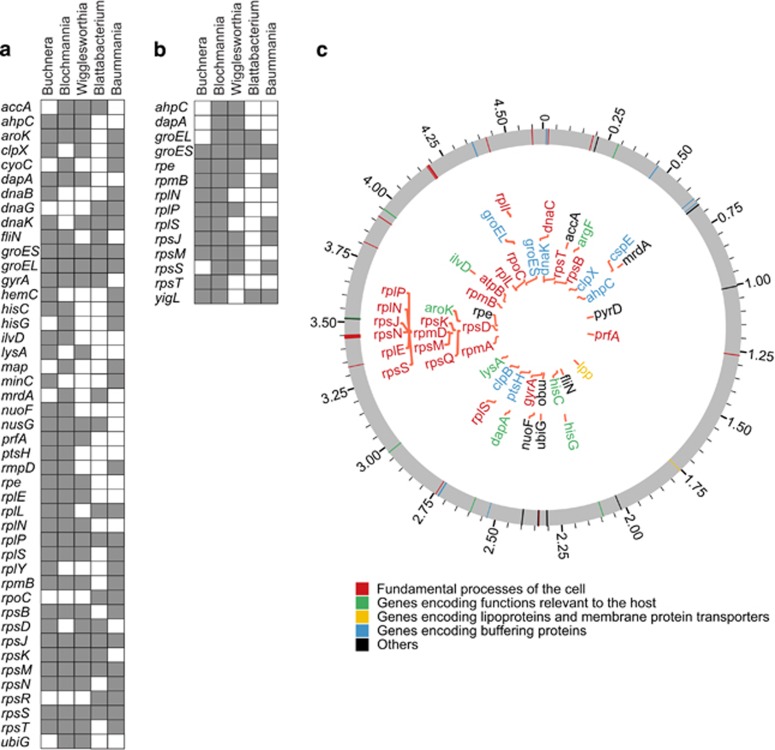
Endosymbiotic bacteria of insects converge in their selective constraints at genes that are unrelated to the insect host. We analyzed the distribution of the selective constraints among endosymbiotic genes and studied the convergences among the five independent endosymbiotic groups. We studied two sets of genes, (a) one in which the ratio between the symbiotic and free-living bacterial non-synonymous-to-synonymous rates ratio (R=ωe/ωf) is R<2, hence this set includes genes with strong selective constraints (R<1) and slightly relaxed constraints (1<R<2), and (b) a set of strongly constrained symbiotic genes when compared with their free-living bacterial orthologs R<1. Gray-colored squares in the matrix indicate genes convergently constrained between two or more endosymbiotic groups; white squares are genomes in which such genes are under relaxed constraints. (c) Convergently constrained genes in endosymbiotic genomes. These genes are color-coded according to their functional classification using GO terms. Only seven genes were relevant to the metabolism of the bacterial host (green-colored genes).